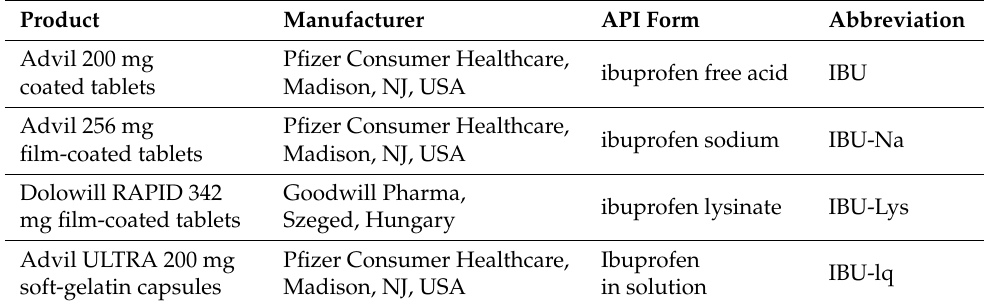
Table 1. Dosage form and active ingredients of the tested